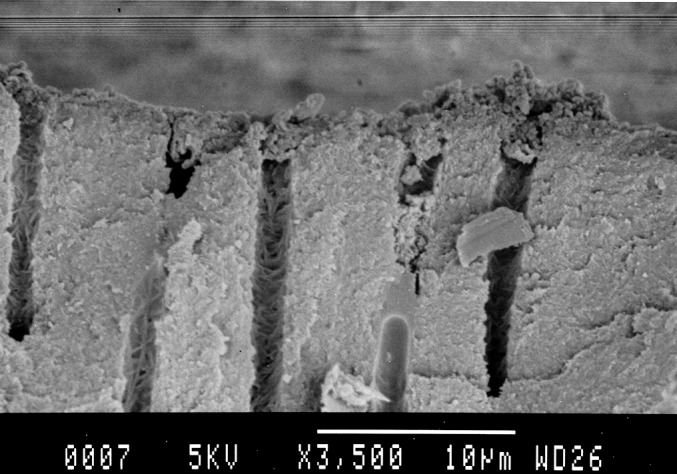
Scanning electron micrographs of the root canals of group B (× 2000) for the laser tube root canal scanning electron microscopy, show that the melting dentin closed the dentinal tubules.